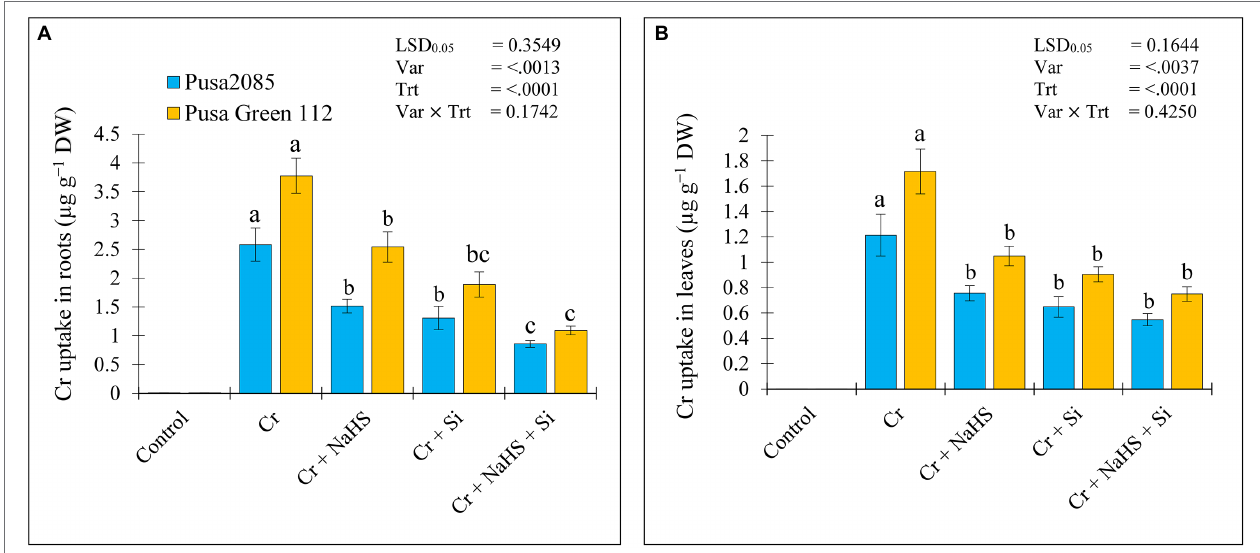
FIGURE 7 | Effect of NaHS, Si, and NaHS + Si treatments on Cr accumulation in roots (A) and leaves (B) of both chickpea plants grown during Cr VI stress. Data are presented as mean ± SE ( n = 5) and different bar letters are indicated statistically differences ( p < 0.05) as tested by the least significant difference